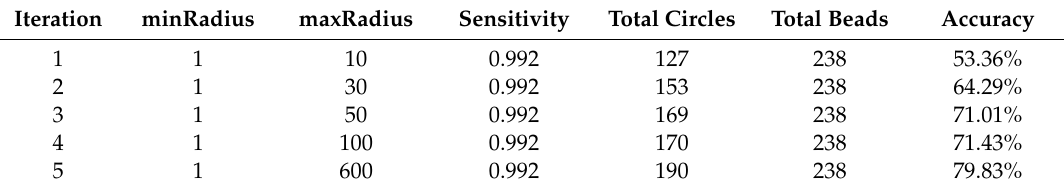
Table 1. Values of di ff erent parameters used during di ff erent iterations.